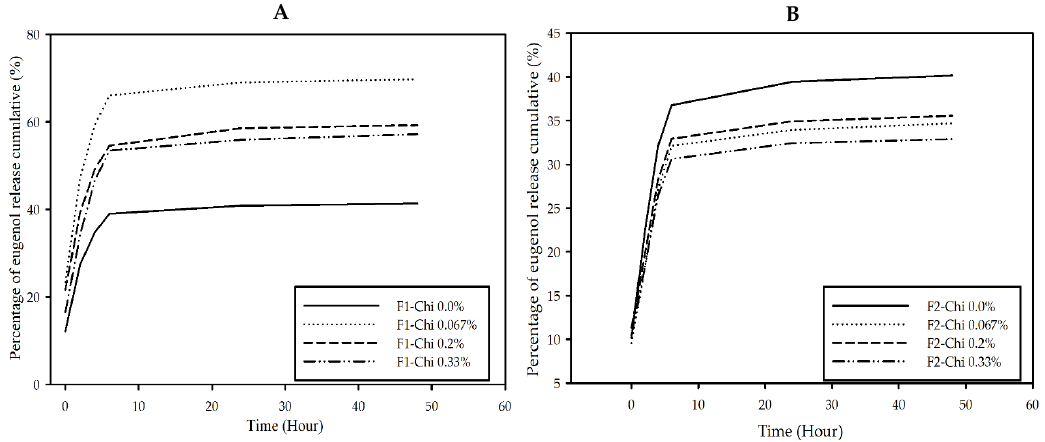
Figure 3. Release profile of eugenol from F1 ( A ) and F2 ( B ) spray-dried powders